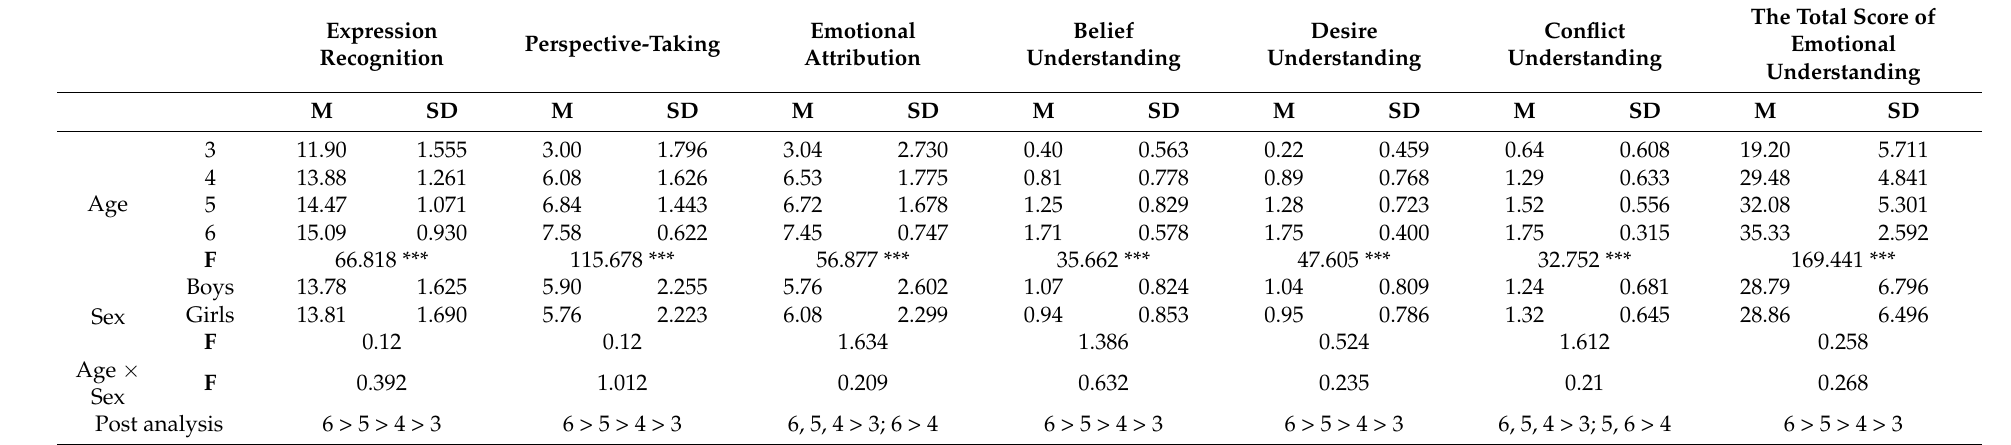
Table 3. General information and difference analysis of emotional understanding.